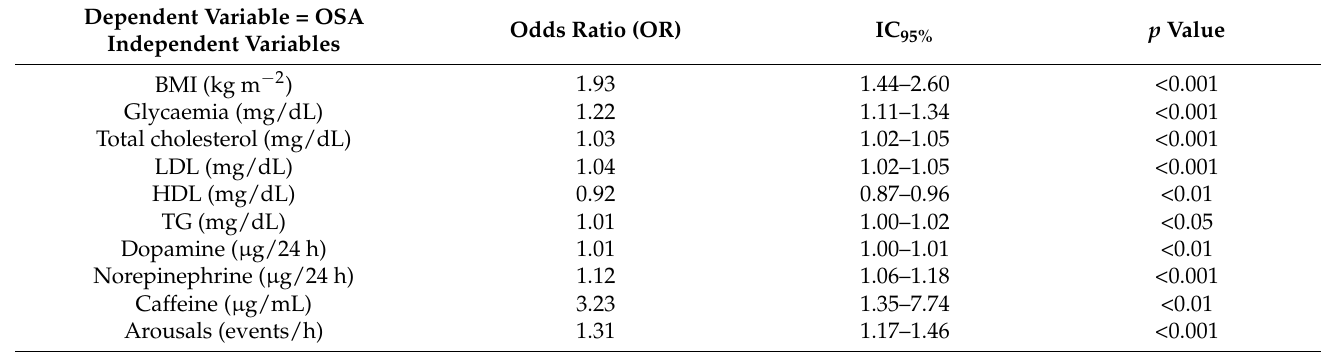
REM, rapid eye movement; NREM, non-rapid eye movement. Table 4. Binary logistic regression for BMI, glycemia, cholesterol, LDL, HDL, TGs, dopamine, NE, caffeine concentration and arousals with OSA as dependent